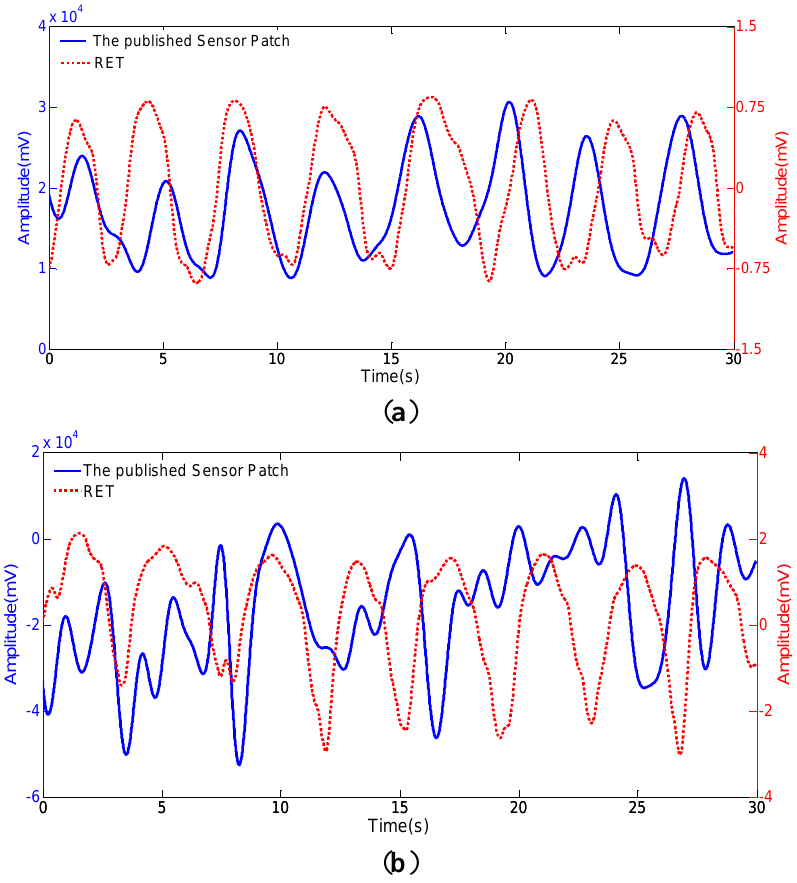
Figure 3. Comparison of the electrical signals acquired from the previously-reported sensor patch, and a commercial respiratory effort transducer under (RET) ( a ) static (sitting), and ( b ) dynamic (walking)